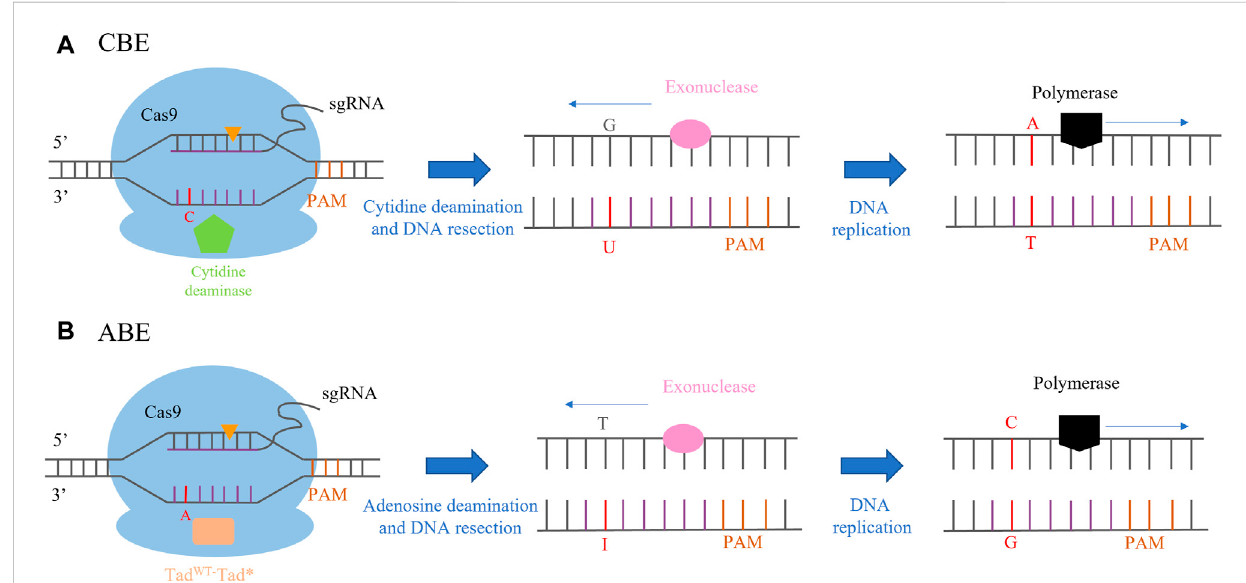
FIGURE 2 CRISPR/Cas-mediated base editing. (A) CBE (cytosine base editor)-mediated C-to-T base-editing strategy. Orange triangles indicate the single- stranded break within the guide RNA recognition sites. (B) ABE (adenine base editor)-mediated A-to-G base-editing strategy. Orange triangles indicate the single-stranded break within the guide RNA recognition